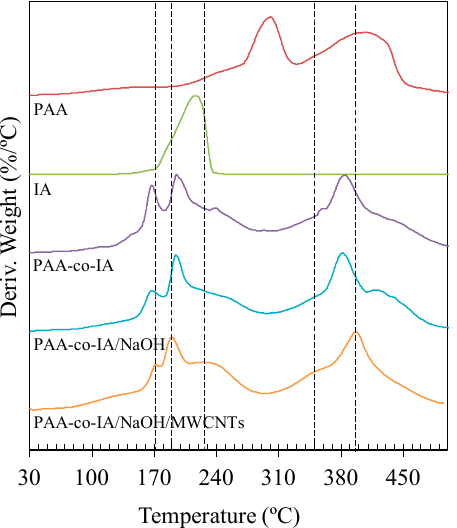
Figure 5. Derivative thermograms (DTG) of the PAA hydrogel, IA monomer, PAA-co-IA hydrogel, PAA-co-IA/NaOH hydrogel, and PAA-co-IA/NaOH/B-MWCNT hydrogel.